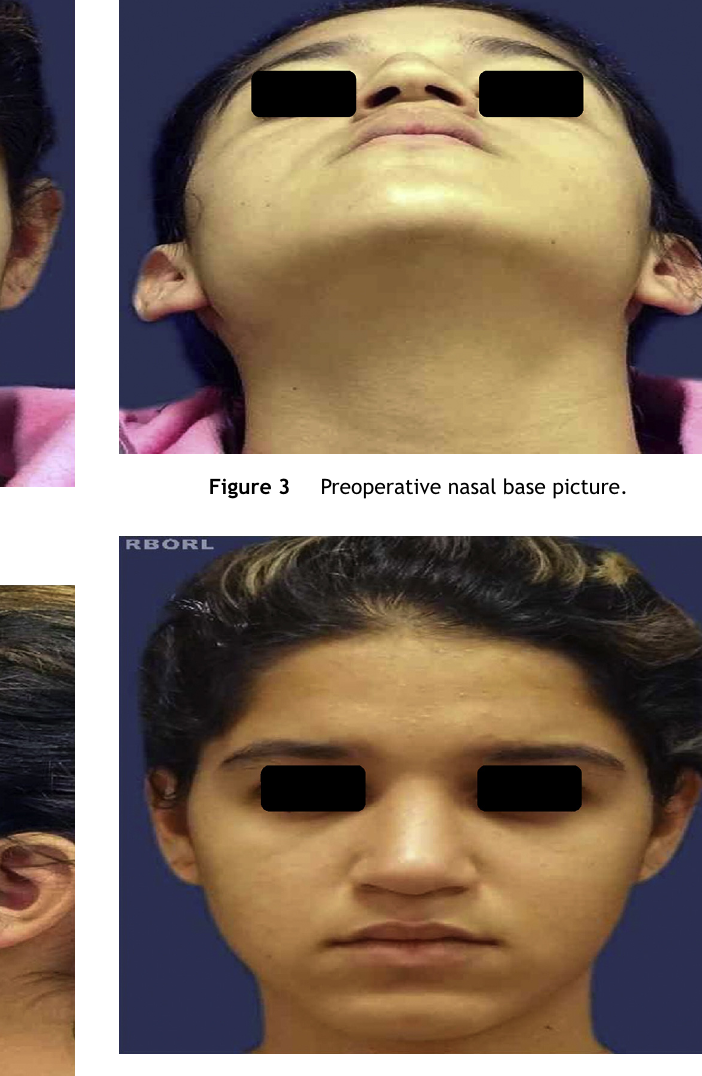
Postoperative frontal